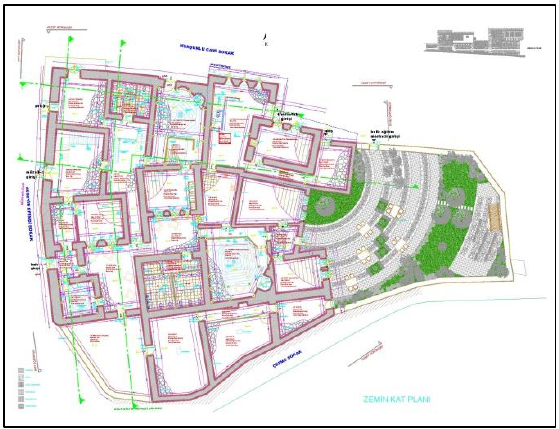
Figure 10. 2D Restoration Drawings-Ground Floor Plan